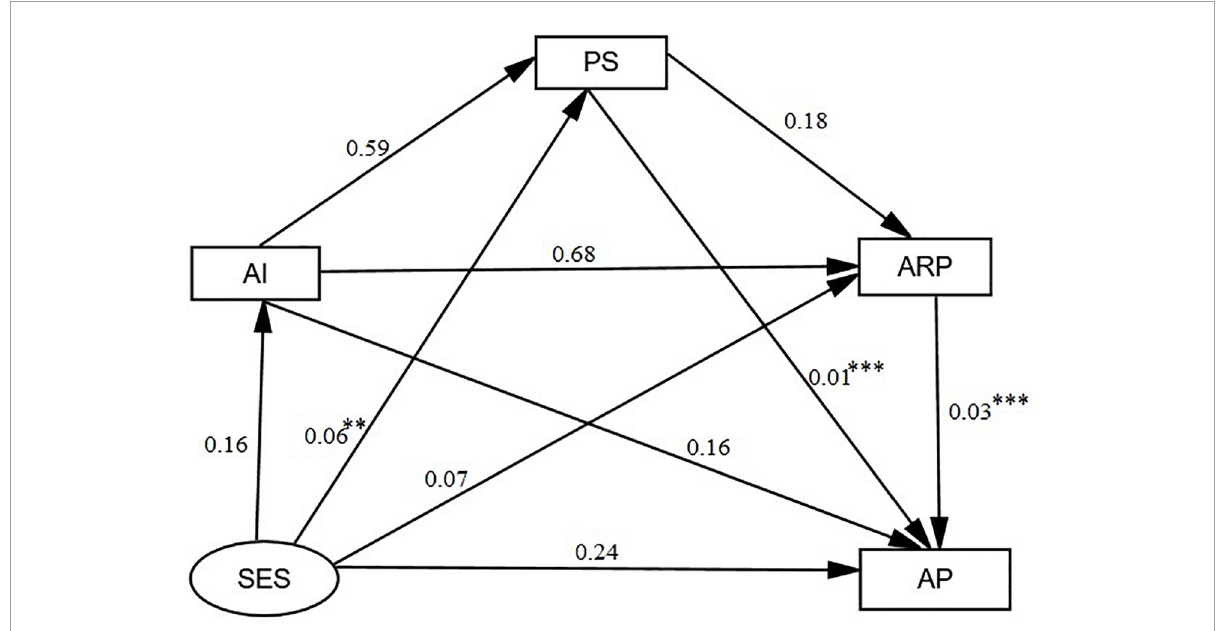
FIGURE1 Structural equation model analysis to test the threshold model. No start = p < 0.001, ** p < 0.05, ***not significance; FE, father education; FI, father monthly income; ME, mother education; MI, mother monthly income; SES, socioeconomic status; AP, academic